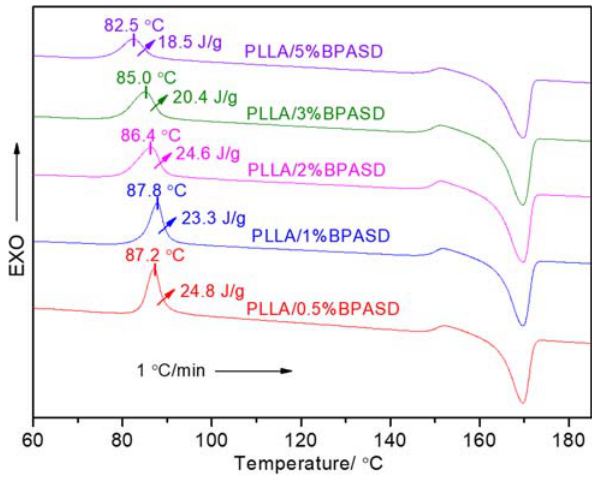
Figure 5: Cold - crystallization DSC curves of PLLA/BPASD